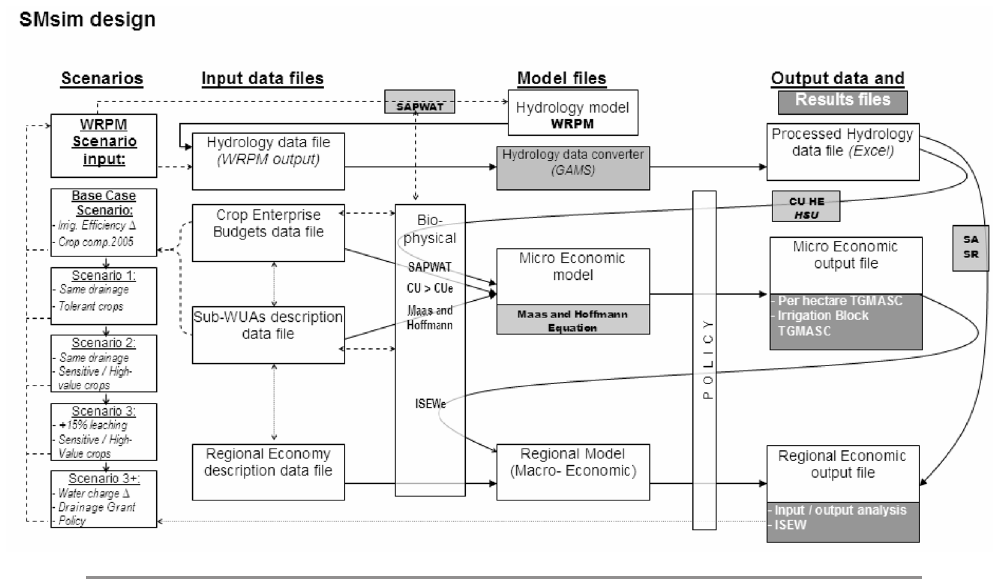
The integrated conceptual